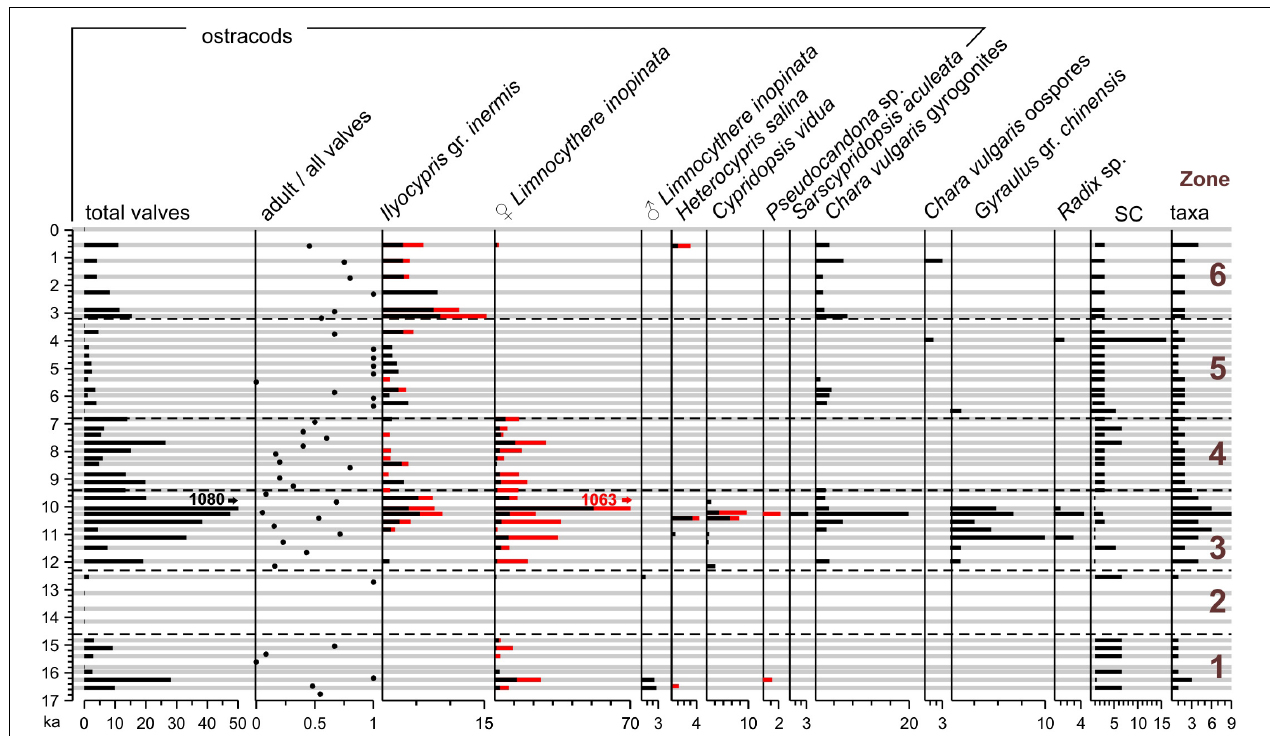
FIGURE 3 | The fossil record from Lake Ulaan. Absolute count data given for 15 g dry sediment material per sample. Black bars indicate adult ostracod valves and red bars show juvenile valves. Underlying gray bars mark positions of samples. Specific conductivity (SC) is estimated based on mutual ranges of known SC tolerance ranges of taxa recorded from individual samples ( Table 1